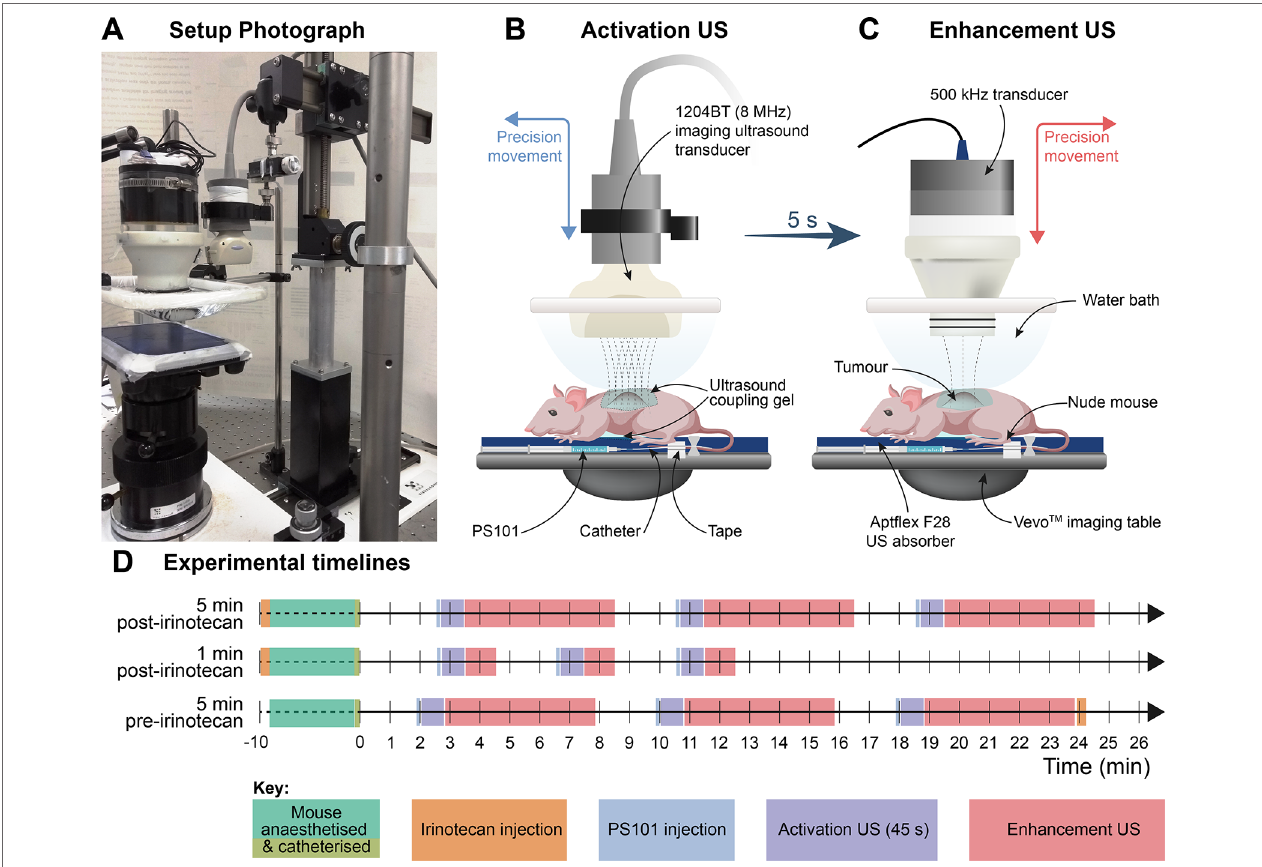
FIgURe 1 | Ultrasound (US) administration apparatus and experimental timelines. (Panel A ) is a photograph of the activation and delivery enhancement setup showing the animal bed with the low frequency transducer in position for delivery enhancement and the clinical transducer to one side which had been transposed with the other transducer after the activation step; (Panels B and C ) are schematics illustrating the positioning of the activation and delivery enhancement transducers, respectively. The water bath and acoustic transmission gel interface permit easy US transducer-to-tumour depth setting and transducer interposition. The tail vein catheter and tail are tapped to the imaging table. (Panel D ) shows the timelines for the procedures.